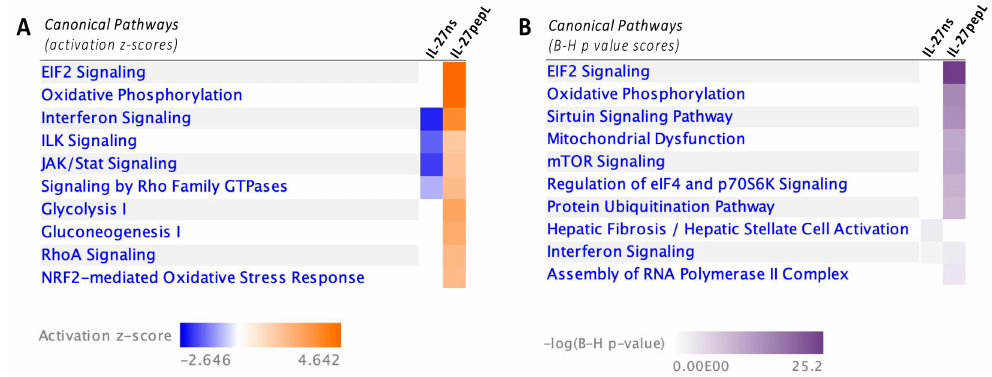
Figure 4. IPA canonical pathway analyses. Analyses of the dataset compared the control IL-27ns to the IL-27pepL therapeutic (both relative to pcDNA control). ( A ) The top five changes by activation z-score ranking (A) were eukaryotic initiation factor 2 (EIF2) signaling, oxidative phosphorylation, interferon signaling, integrin linked kinase (ILK) signaling, and Janus kinase (JAK) / STAT signaling. Color bar: activation z-score. ( B ) When the Benjamini–Hochberg (B-H) p -value score analysis was used, we observed the highest significant changes to include EIF2, oxidative phosphorylation, and mitochondrial dysfunction among the top five. Color bar: B-H p -value scores.